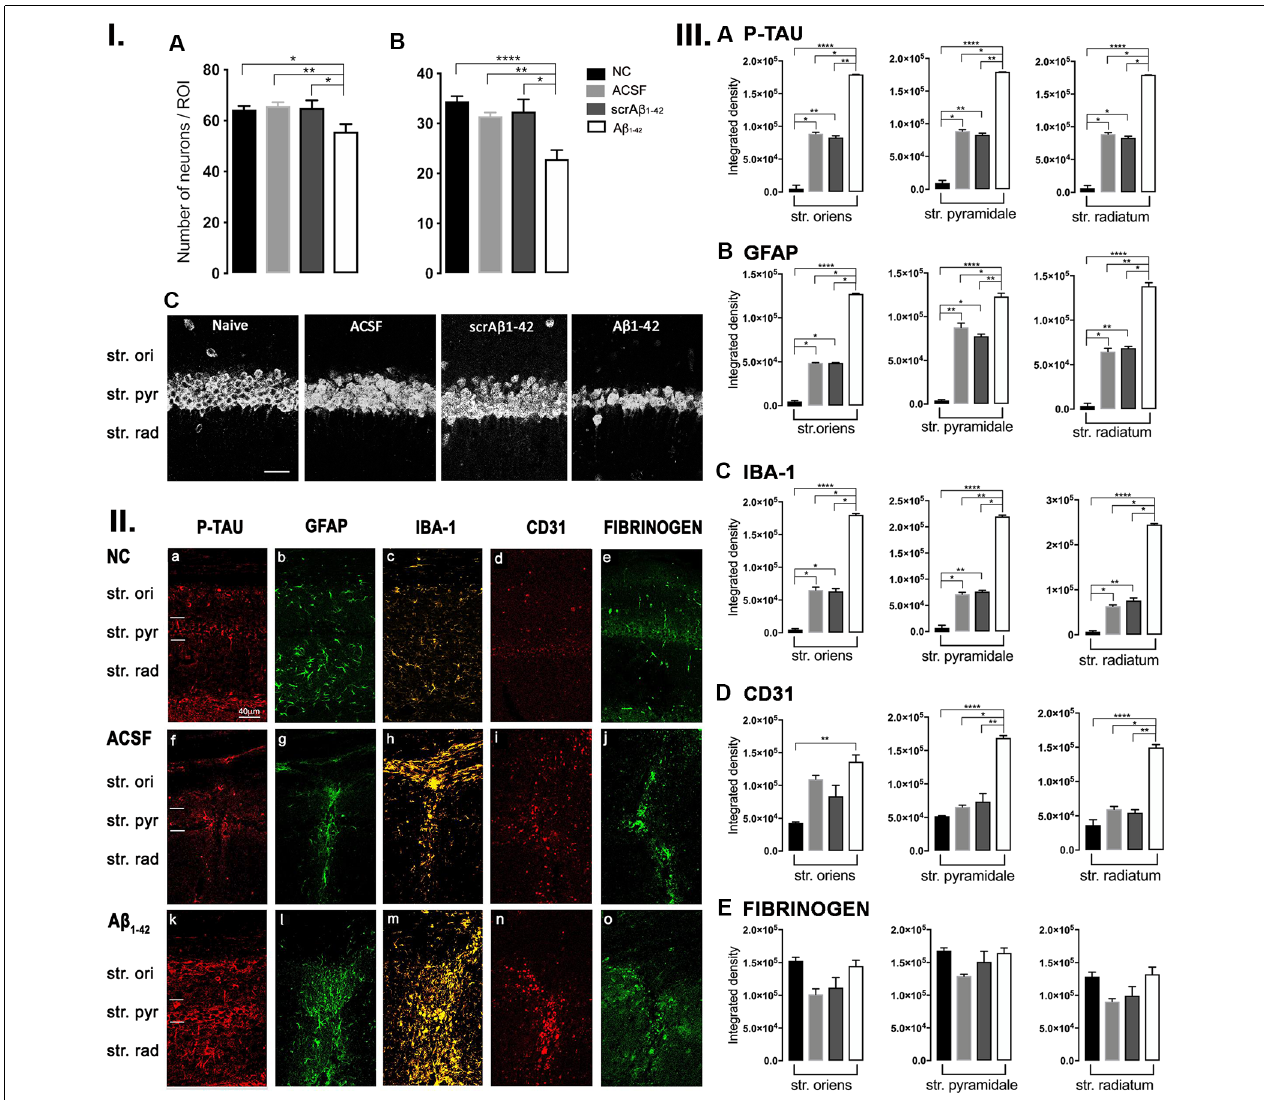
FIGURE 5 | Panel I: Graphs showing the number of NeuN-positive pyramidal cells in the str. pyramidale of the CA1 hippocampal layer in NC, ACSF-, scrA β 1–42 - and A β 1–42 -injected mice 7 days post-injection (A) and 30 days post-injection (B) . Representative images of the CA1 hippocampal subregion at a location adjacent to the injection site showing NeuN-positive pyramidal cells from the str. pyramidale in NC, ACSF-, scrA β 1–42 - and A β 1–42 -injected mice 30 days post-injection (C) . Panel II: Representative images showing immunolabeling of p-tau, GFAP, Iba-1, CD31, and fibrinogen at the injection site 30 days post-injection in NC (a–e) , ACSF-injected (f–j) , and A β 1–42 -injected (k–o) mice. Scale bar (40 µ m). Panel III: Graphs showing quantification at the injection site in the CA1 hippocampal region of p-tau, GFAP, Iba-1, CD31, and fibrinogen, 30 days post-injection in NC, ACSF-, scrA β 1–42 - and A β 1–42 -injected mice. Data expressed as mean ± SEM (Kruskal–Wallis test; * p < 0.05; ** p < 0.01, **** p < 0.0001, n = 6).